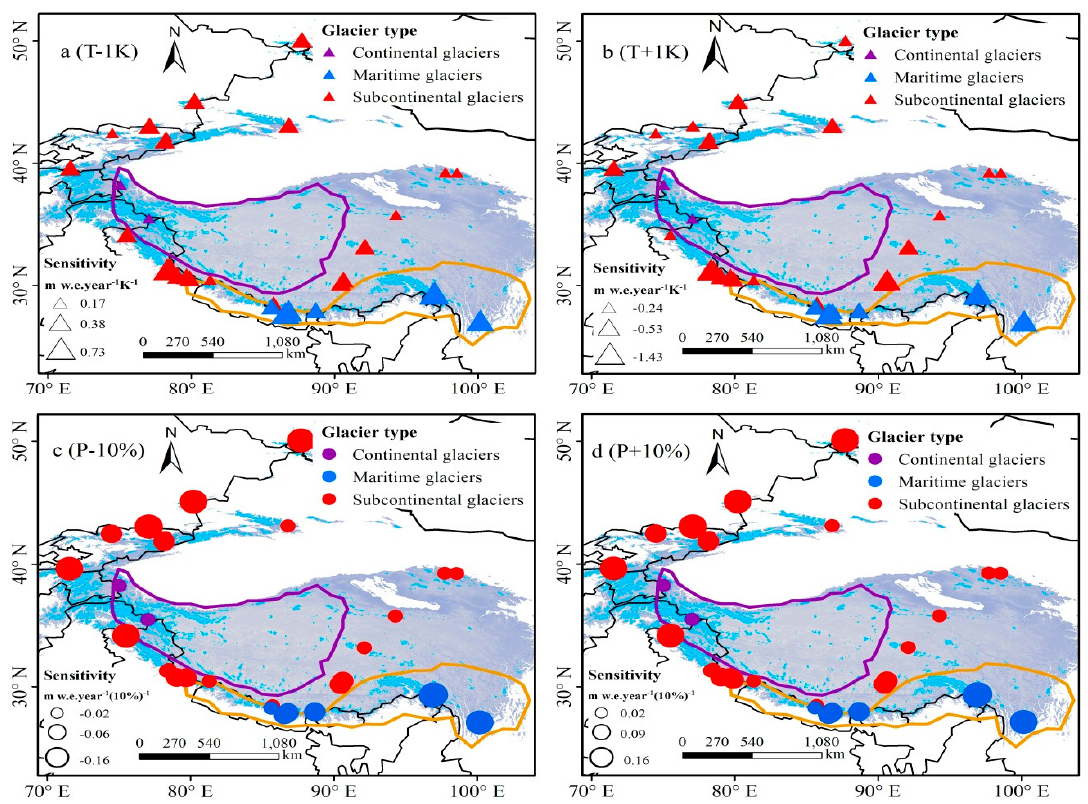
Figure 4. Spatially heterogeneity in mass balance sensitivity of the 45 glaciers to ( a , b ) temperature change and ( c , d ) precipitation change.